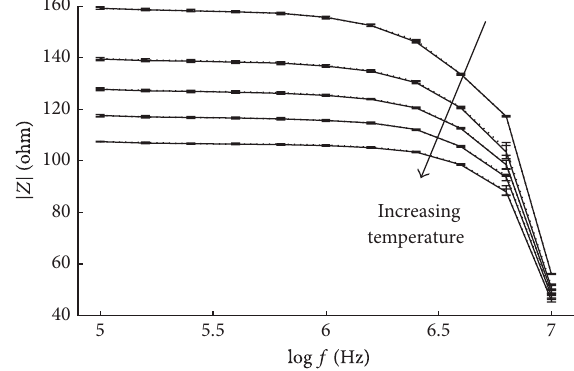
F 5: Impedance modulus spectrum for the samples at 78mg/dL, in static (dotted curve) and dynamic (solid curve) conditions at room temperature and at 32, 37, 42, and 47 top to bottom). Data reported are mean